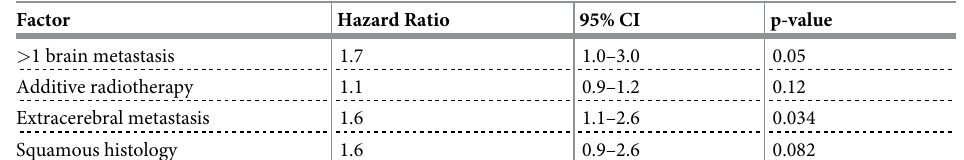
Table 4. Multivariate